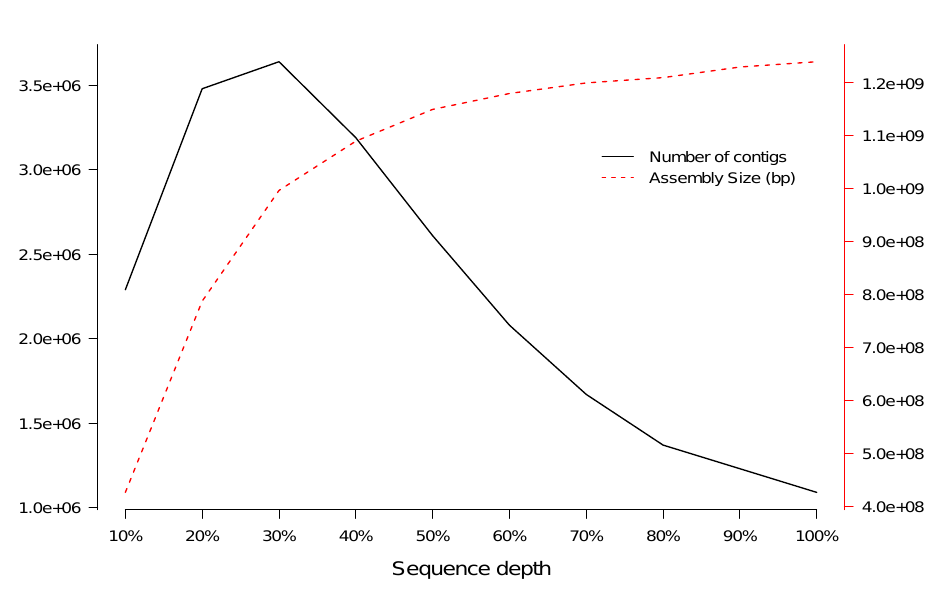
Figure 3: The dependency of the number and total size of contigs on sequencing depth which is represented by different subsets of the read data size. It shows how the number of contigs (solid line and left scale) and assembly size (dotted line and right scale) change with the data size in different